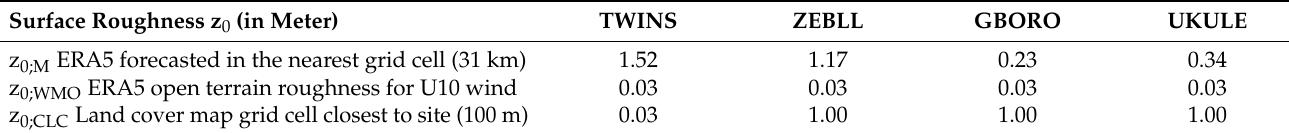
Table 4. Surface roughness from ERA5 grid cells and local value derived from the land cover maps. Surface Roughness z 0 (in Meter)